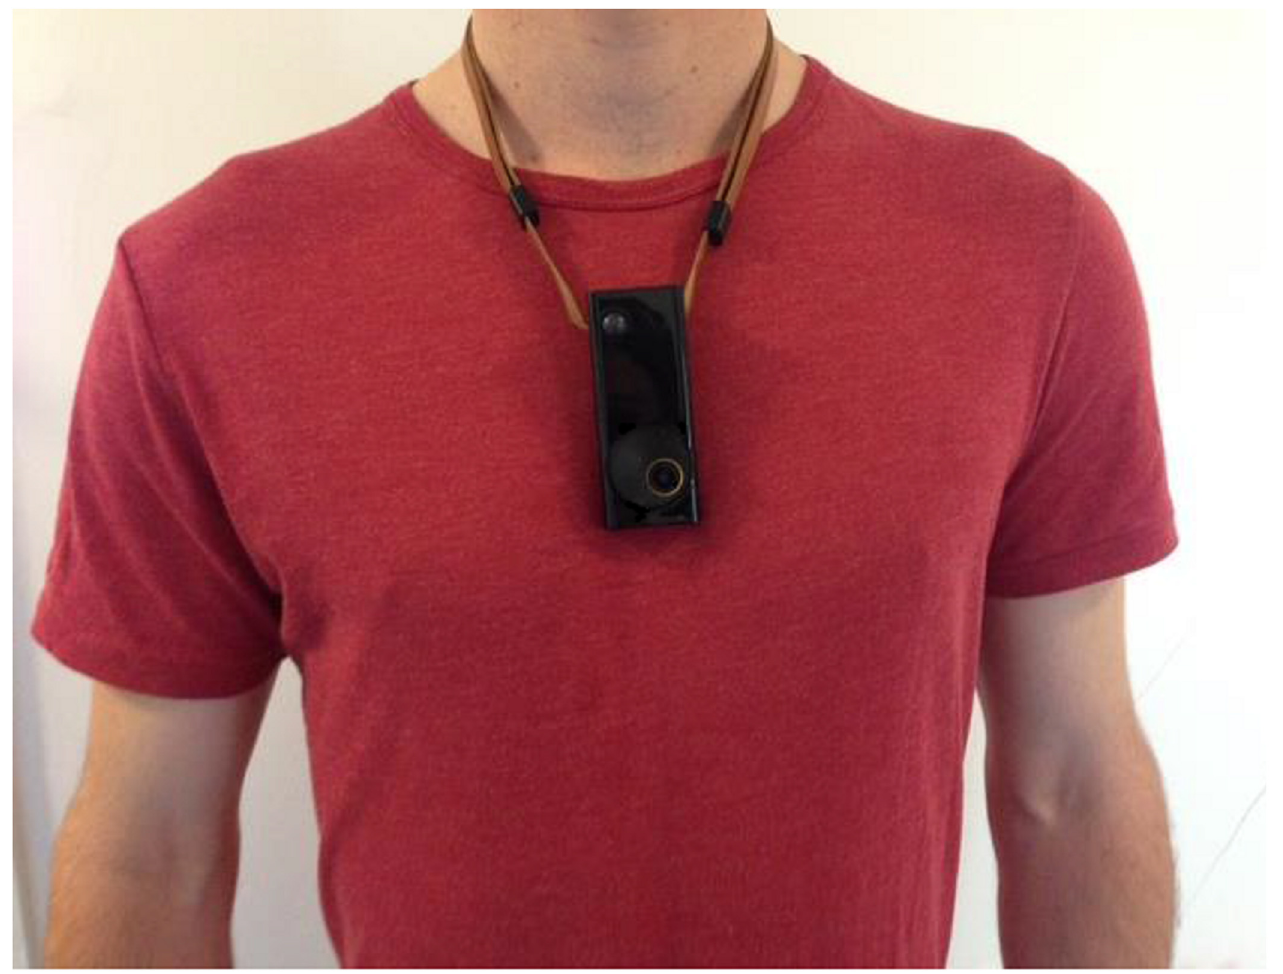
Fig 1. The Autographer wearable camera on adjustable